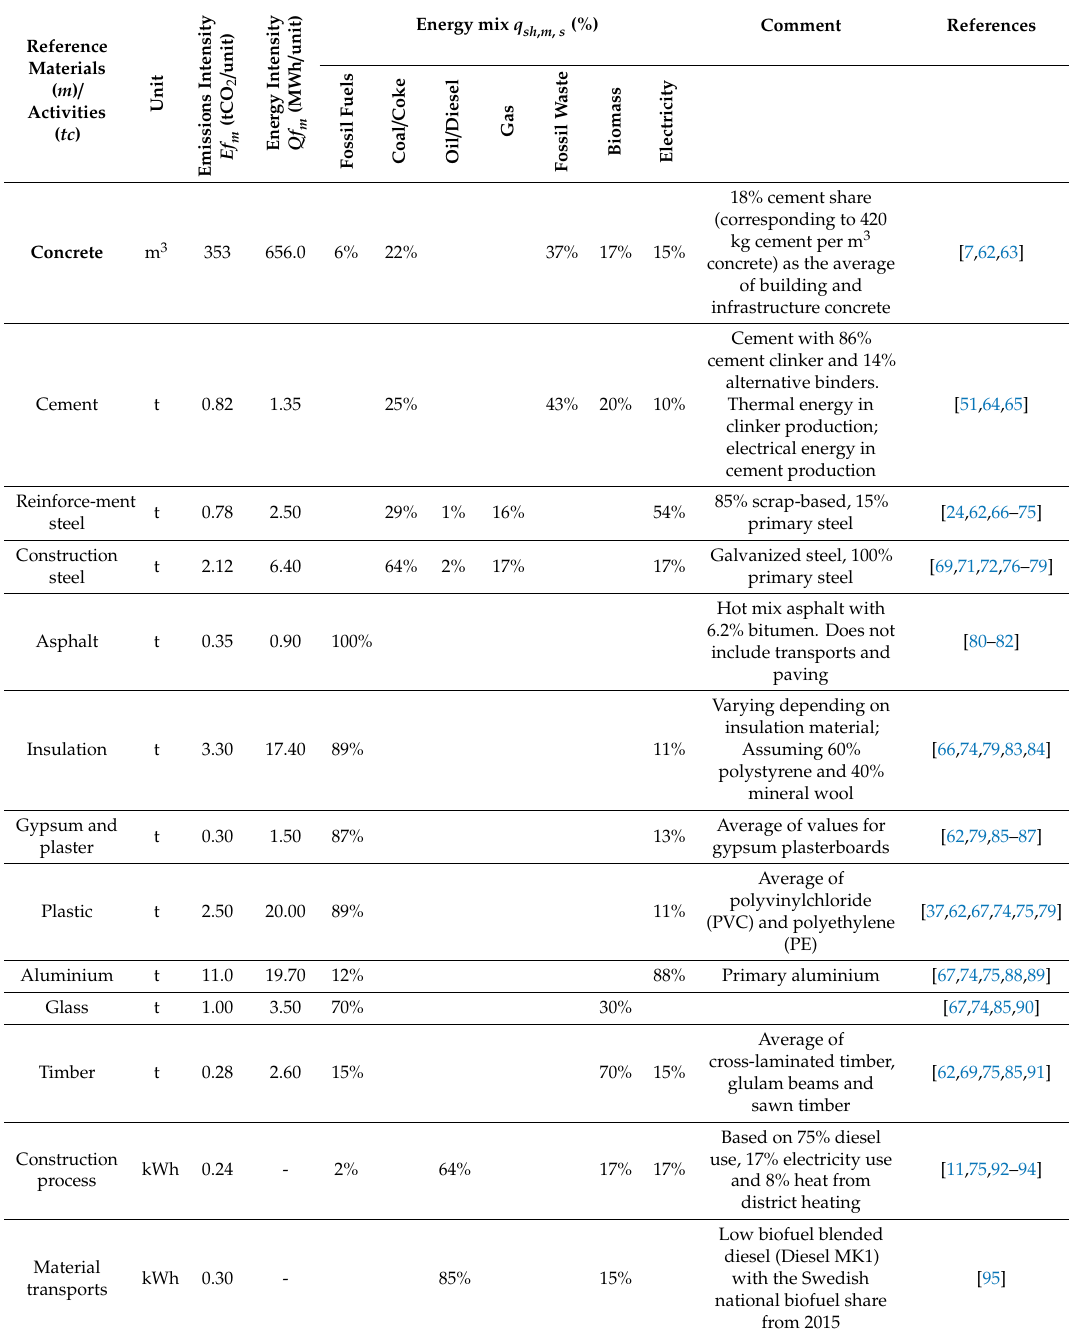
Table 1. Emissions and energy intensity factors along with energy mix in the production of reference materials and energy carriers used in the construction of buildings and transport infrastructure in the base year of